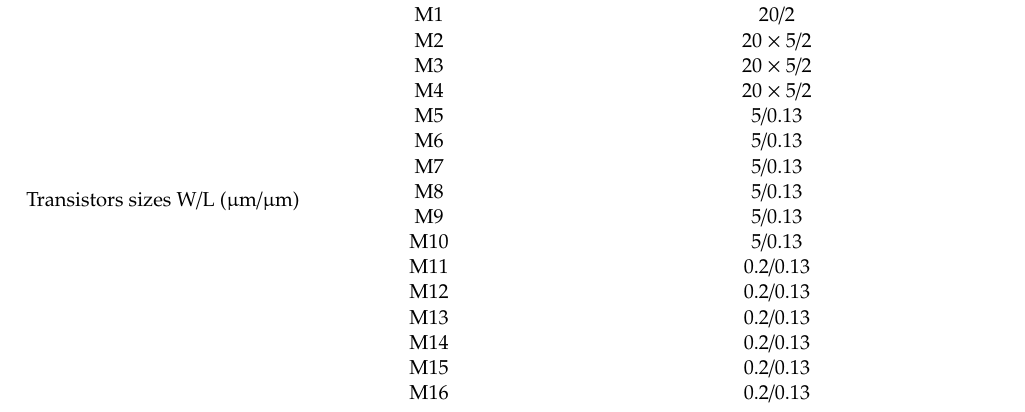
Table 2. Component sizes and simulated performance specifications.